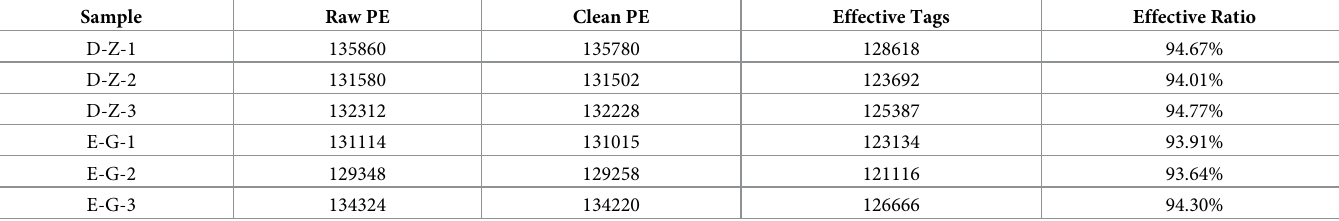
Table 1. Basic sequencing data of medium-temperature Daqu and high-temperature Daqu. Sample Raw PE Clean PE Effective